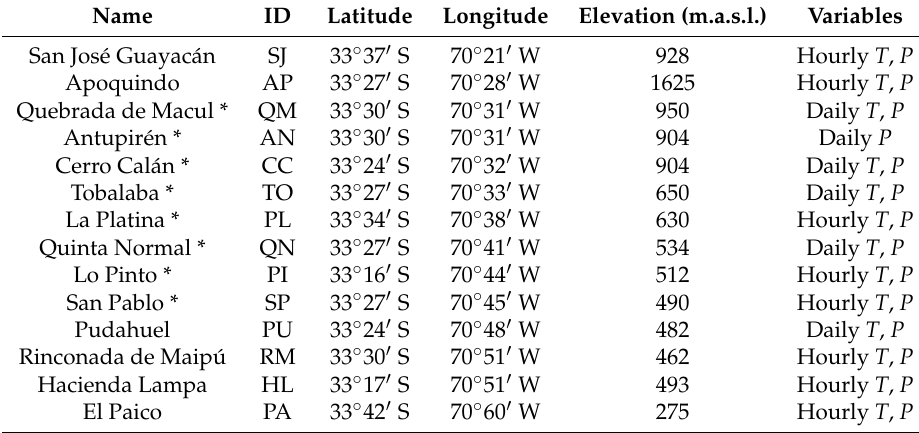
Figure 1. Quebrada de Ramón’s basin (outlined in red), in Santiago de Chile’s Piedmont, and the location of Apoquindo meteorological station and the other 13 meteorological stations in Santiago’s valley and foothills. White crosses are latitude/longitude coordinates. Table 1. Meteorological stations names, coordinates and recorded variables: T (air temperature) and P (precipitation). Stations located inside Santiago are indicated with